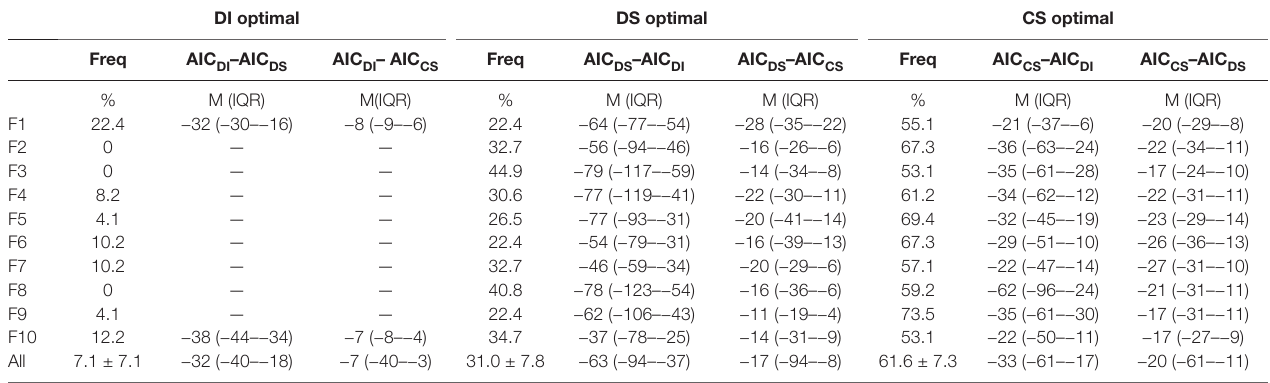
TaBle 5 | Model Quality Results: Frequency of model superiority, and margin of improvement; F = Feature. Di optimal Ds optimal cs optimal